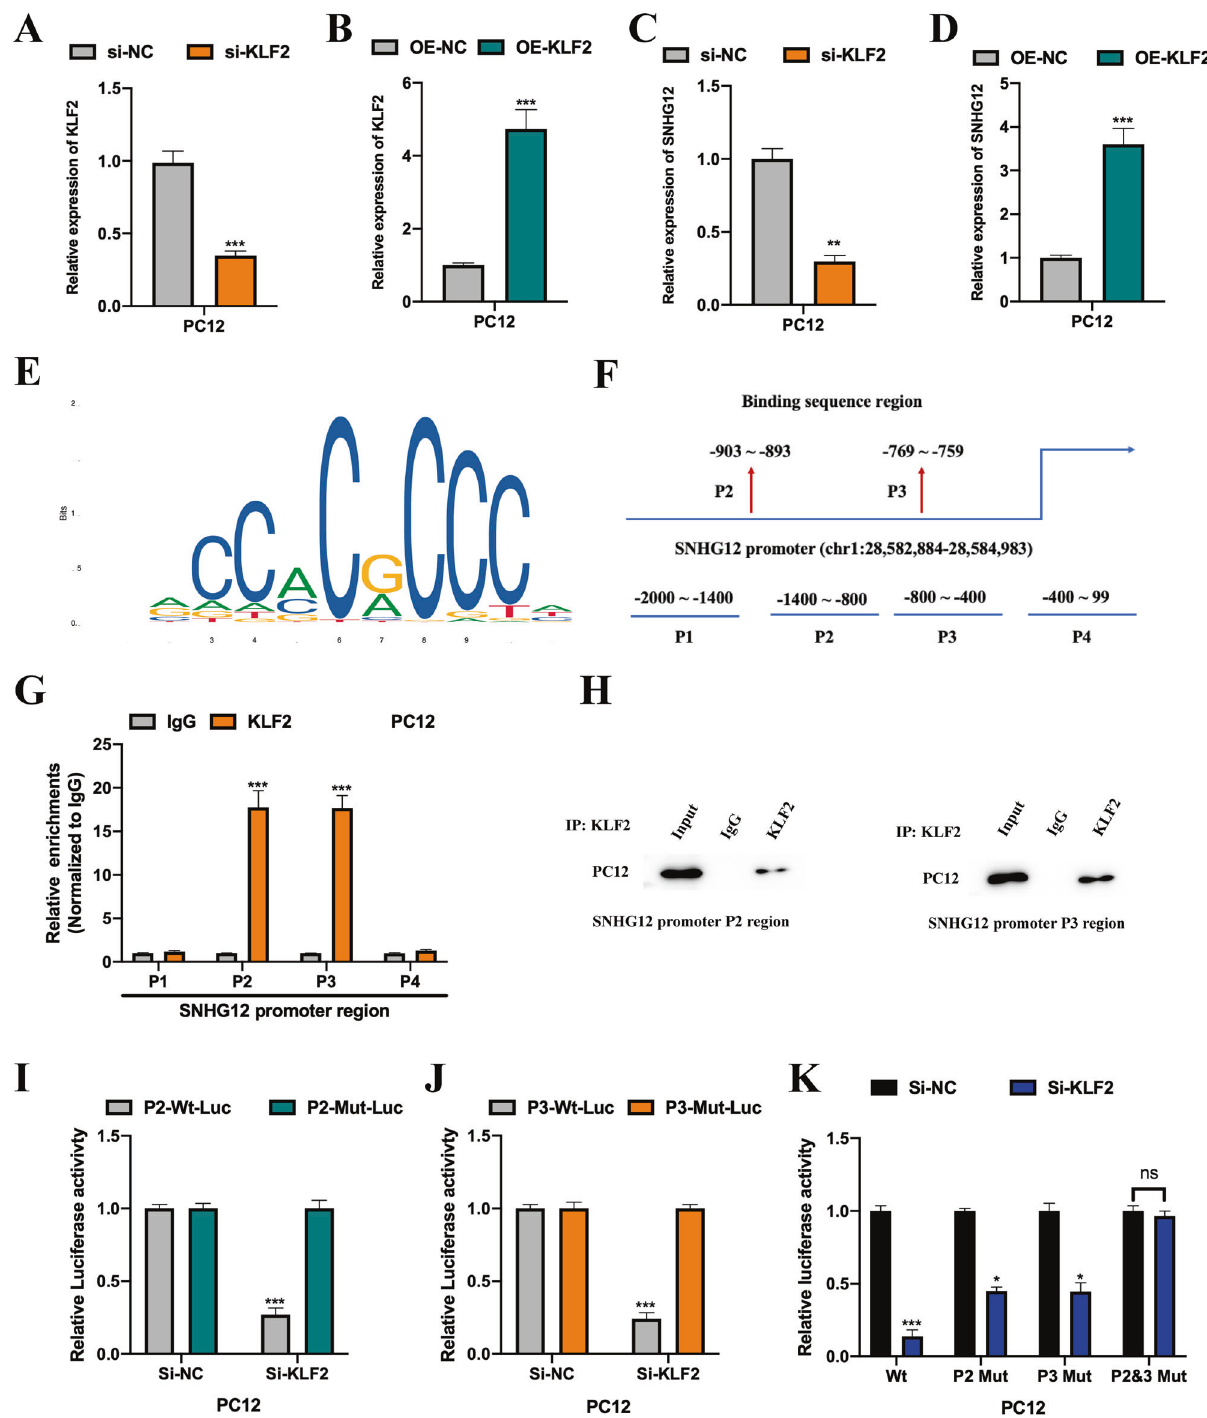
Fig. 3 KLF2 mediates lncRNA SNHG12 expression in PC12 cells. The relative expression level of KLF2 in KLF2 downregulated ( A ) or upregulated ( B ) PC12 cells was measured by qRT-PCR. The relative expression levels of lncRNA SNHG12 in KLF2 downregulated ( C ) or upregulated ( D ) PC12 cells were measured by qRT-PCR. E The predicted binding sequence of KLF2 is shown. F The putative binding regions of the SNHG12 promoter are presented. ChIP assay followed with qRT-PCR ( G ) and western blot ( H ) were conducted to evaluate the enrichment of SNHG12 promoter regions (P1 – P4) in anti-IgG or anti-KLF2 bounds. I – K Luciferase reporter gene assay was performed to verify the interactions between KLF2 and the P2 or P3 promoter regions of SNHG12 in PC12 cells. Experimental data are presented as mean ± SD. * P < 0.05, ** P < 0.01, *** P < 0.001.